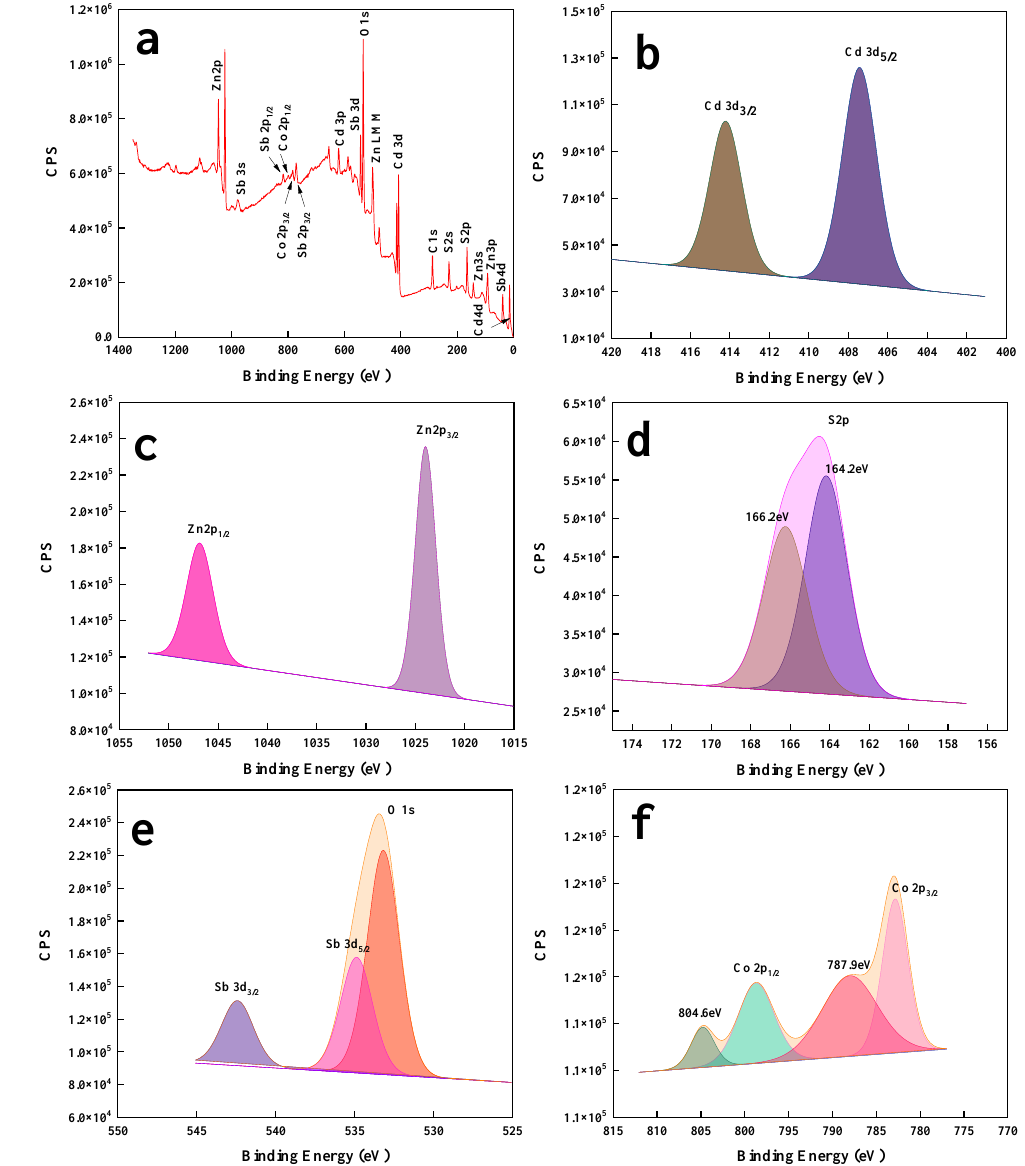
Figure 8. The wide scan XPS of ZCS/1CSO ( a ), the high-resolution XPS spectra of Cd3d ( b ) (the grey and deep purple area represented the main peaks of Cd3d 3/2 and Cd3d 5/2 ), the high-resolution XPS spectra of Zn2p ( c ) (the pink and light purple area represented the main peaks of Zn 2p 1/2 and Zn 2p 3/2 ); the high-resolution XPS spectra of Zn2p ( d ) (the light grey and purple area represented two split peaks of S2p at 166.2 eV and 164.2 eV); the high-resolution XPS spectra of O1s/Sb3d ( e ) (the purple, light red and light orange area represented the main peak of Sb3d 3/2 , Sb3d 5/2 and O1s); the high-resolution XPS spectra of Co2p ( f ) (the deep green and red area represented the satellite peaks of Co2p 1/2 and Co2p 3/2 , the light green and light pink area represented the main peak of Co2p 1/2 and Co2p 3/2 ;